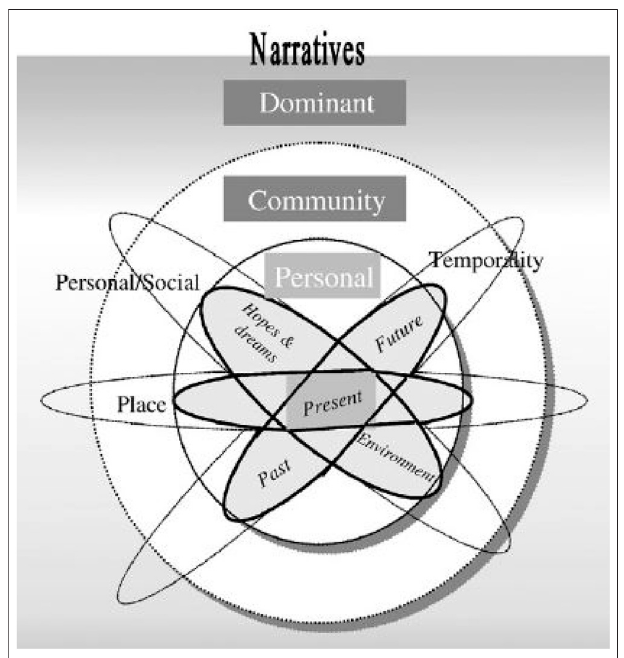
FIGURE 1 | Dimensions of a Narrative Inquiry.